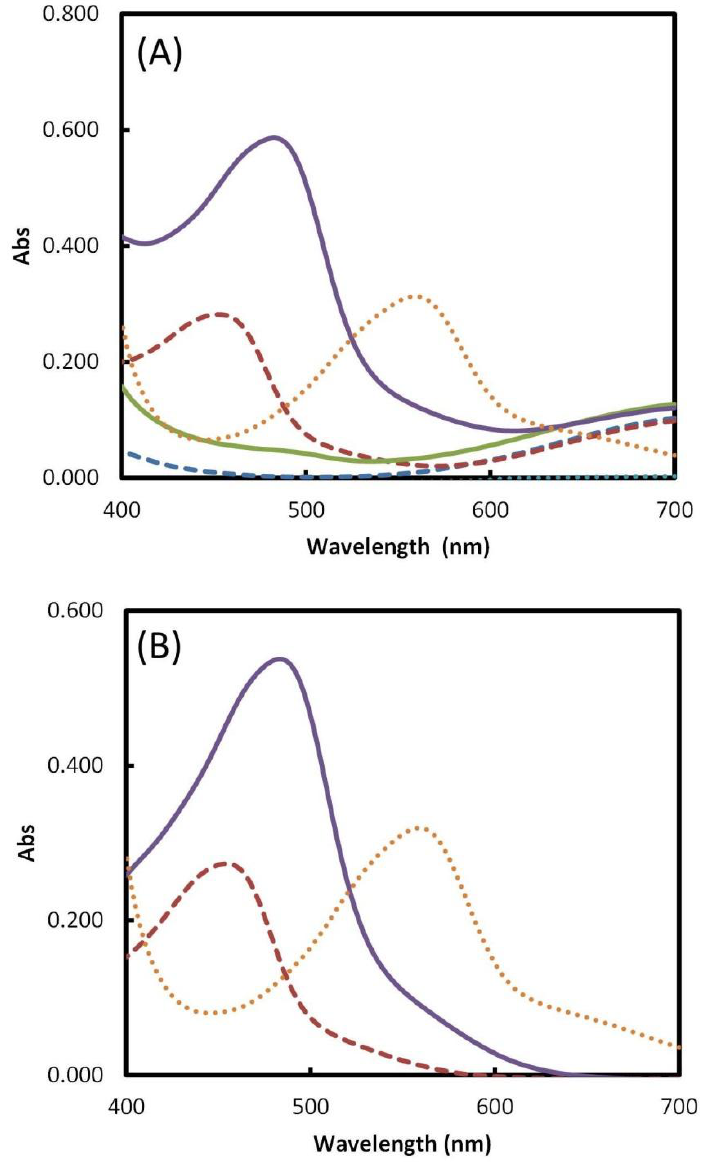
Figure 1. Absorption spectra for Cu(I) complexes and corresponding blank solutions ( A ); net absorption spectra ( B ); NC blank dashed blue line; NC in presence of ascorbic acid dashed red line; BCS blank solid green line; BCS in presence of ascorbic acid solid purple line; BCA blank dotted blue line; BCS in presence of ascorbic acid dotted orange line (reaction conditions given in Table S1 in presence of 50 µM ascorbic